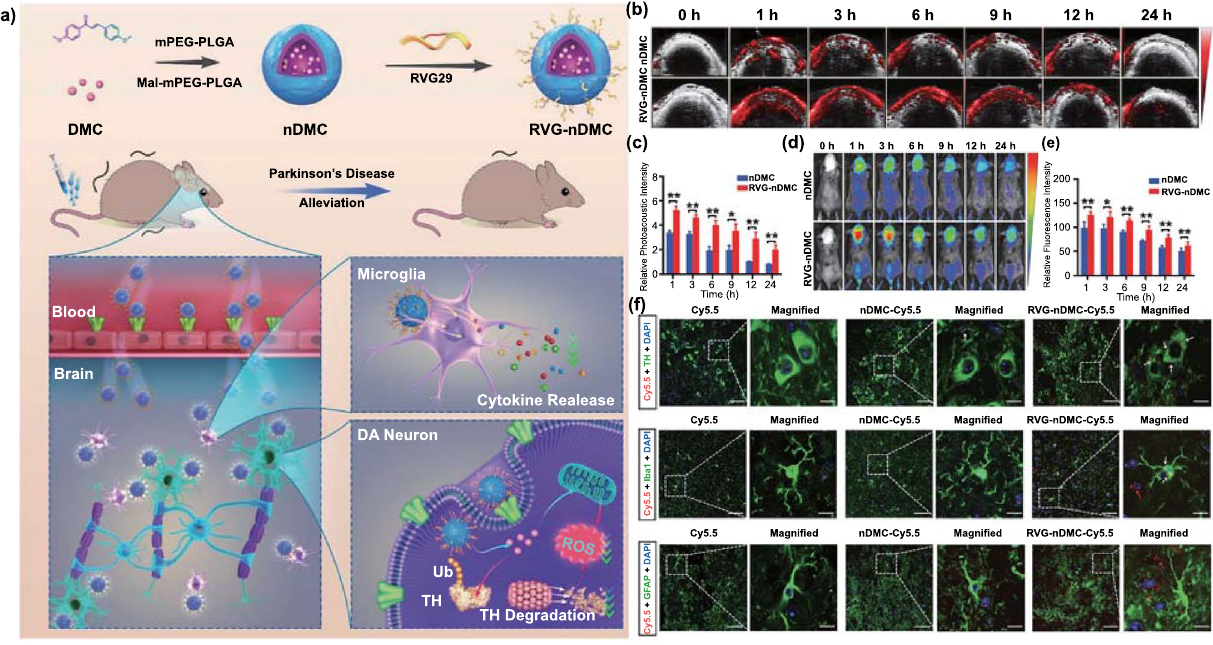
Fig. 4 Example of RMT. a Preparation and proposed mechanism of RVG-nDMC for PD intervention. b Real-time photoacoustic imaging and c corresponding photoacoustic signal analysis of mice after intravenous injection of nDMC or RVG-Ndmc. d Real-time fluorescence imaging and corresponding fluorescence analysis of mice after intravenous injection of Cy5.5-labeled nDMC or RVG-nDMC. f Representative images of TH, Iba1, and GFAP staining in the SN of mice treated with Cy5.5, nDMC-Cy5.5, or RVG-nDMC-Cy5.5 at 6 h post-injection. White arrows in the enlarged parts of the right column show the presence of NPs in DA neurons and microglia. Red arrows show the presence of NPs outside astro- cytes and microglia. Reproduced from Ref.